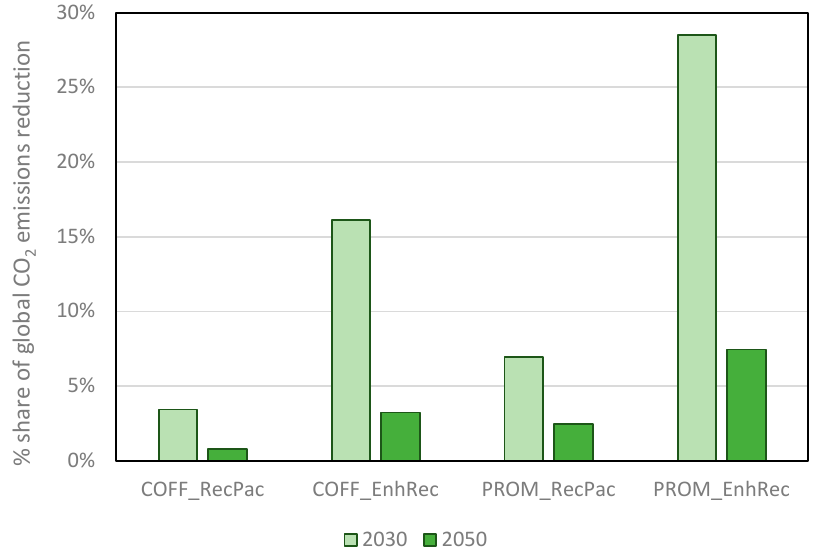
Figure 2. Closing the ambition gap—Share of global CO 2 emissions reduction from CurPol levels achieved in RecPac and EnhRec scenarios compared to reductions required to achieve the 1.5 degree target in a cost-optimal way in 2030 and